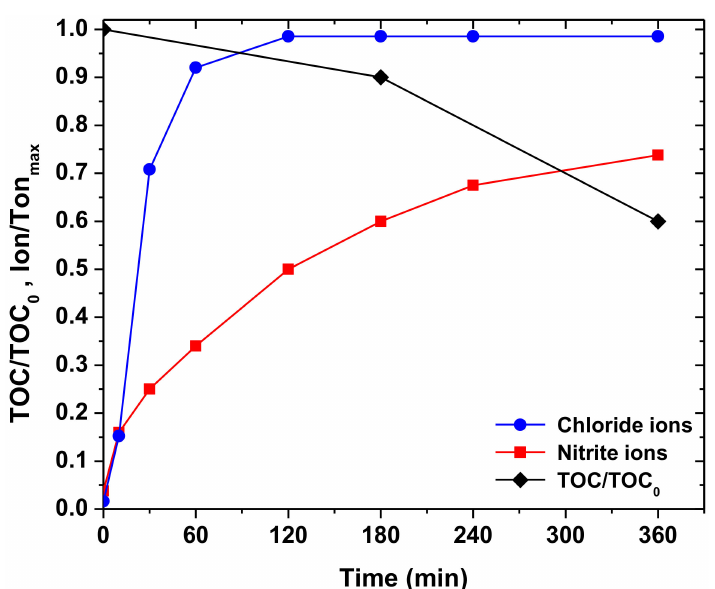
Figure 7. The effect of operational parameters on degradation kinetic rate (k) of anti-inflammatory drug mixture, ( a ) effect of mixture concentration (C(PEF/TiO 2 20 wt% = 600 mg L − 1 ); ( b ) effect of catalyst loading (C o (drug) = 5 mg L − 1 ); and ( c ) effect of pH, during photocatalytic treatment (C o (drug) = 5 mg L − 1 , C((PEF/TiO 2 20 wt%) = 600 mg L − 1 ).